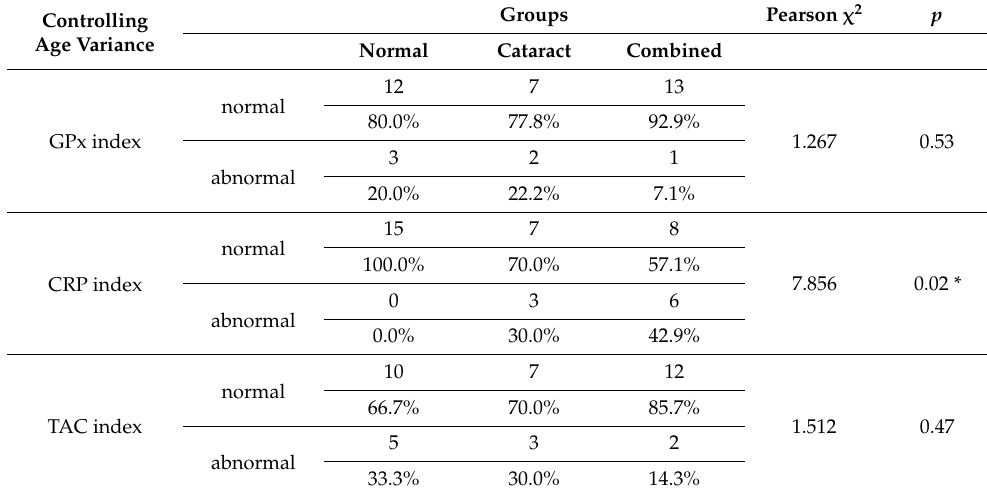
Table 4. Pearson χ 2 analysis of blood results between each group.